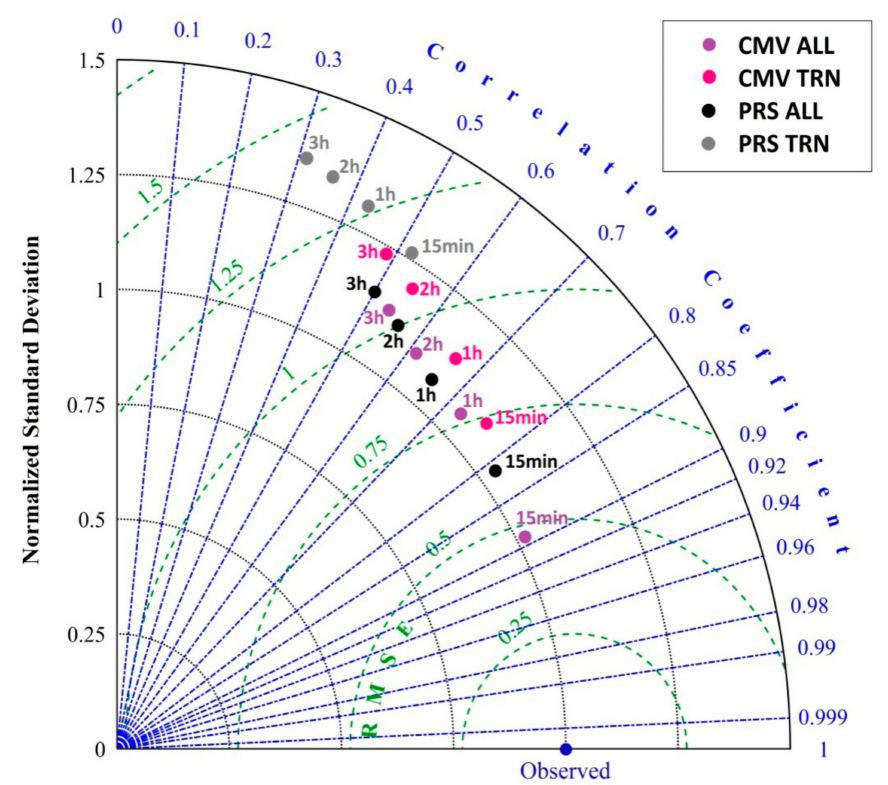
Figure 13. Taylor diagram for the overall CMF error for PRS and CMV approaches under all and TRN